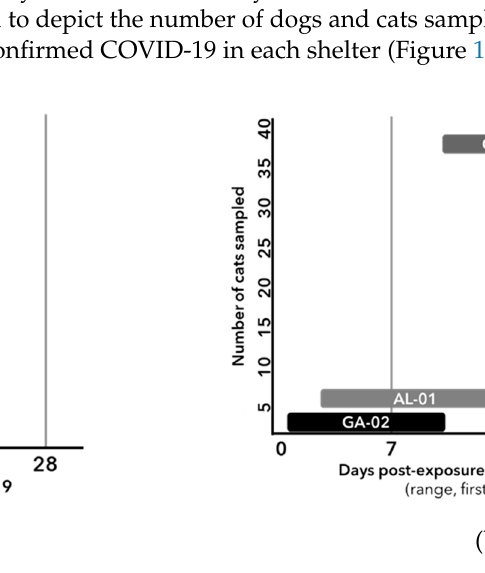
Figure 1. Timelines depicting number of dogs ( a ) and cats ( b ) sampled by days post-exposure to person(s) with confirmed COVID-19 during an investigation of SARS-CoV-2 transmission in congregate animal settings in USA,